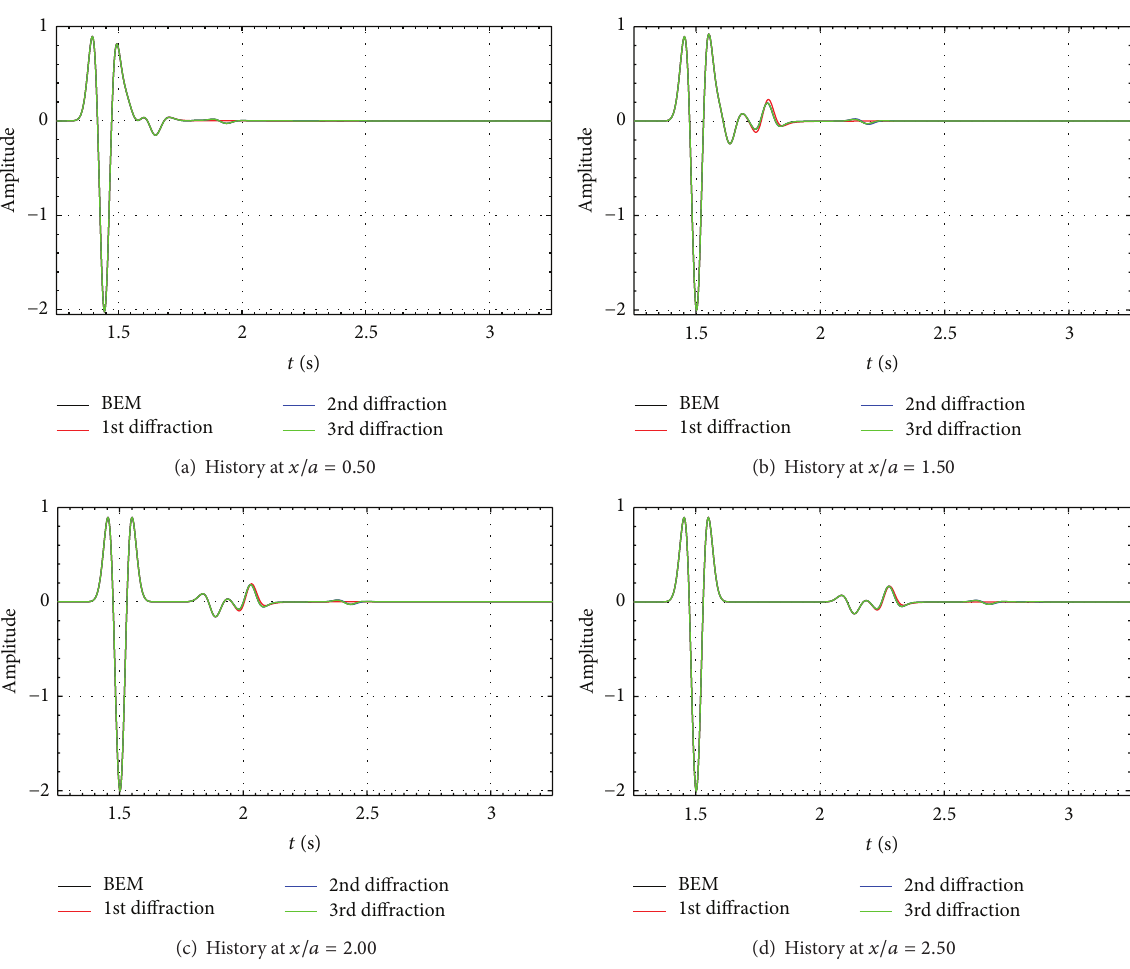
Figure 14: Synthetic seismograms at selected receivers over the canyon surface obtained with the BEM algorithm and the current SBD approach.